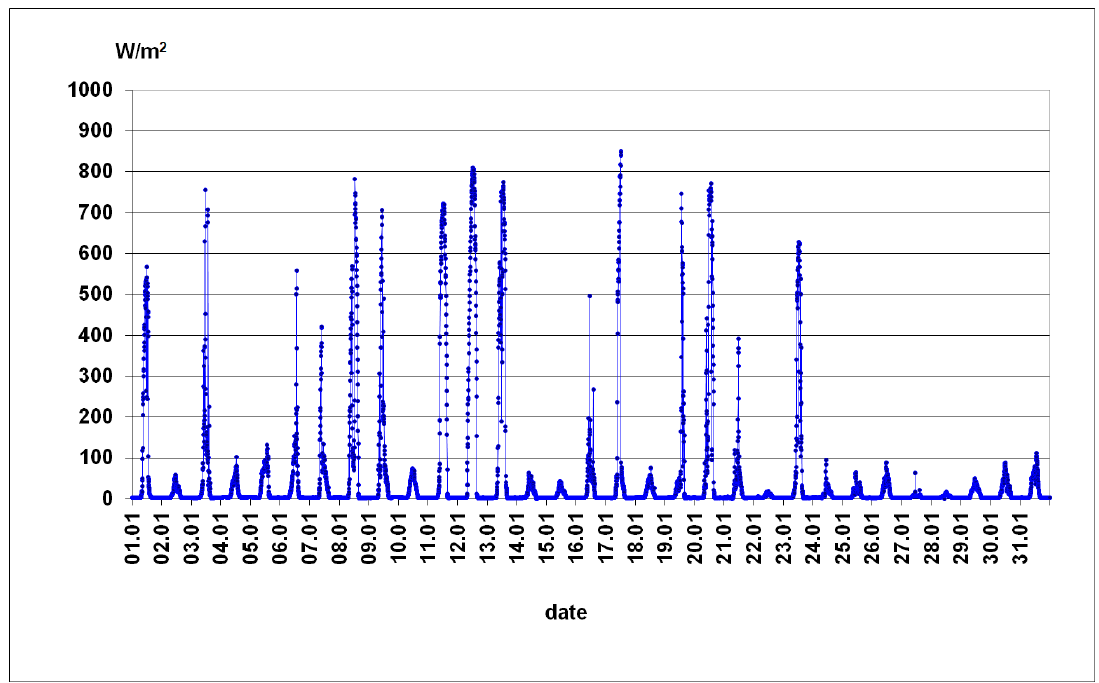
Figure 17. Graph of the global solar irradiance incident on the southern vertical plane in January.